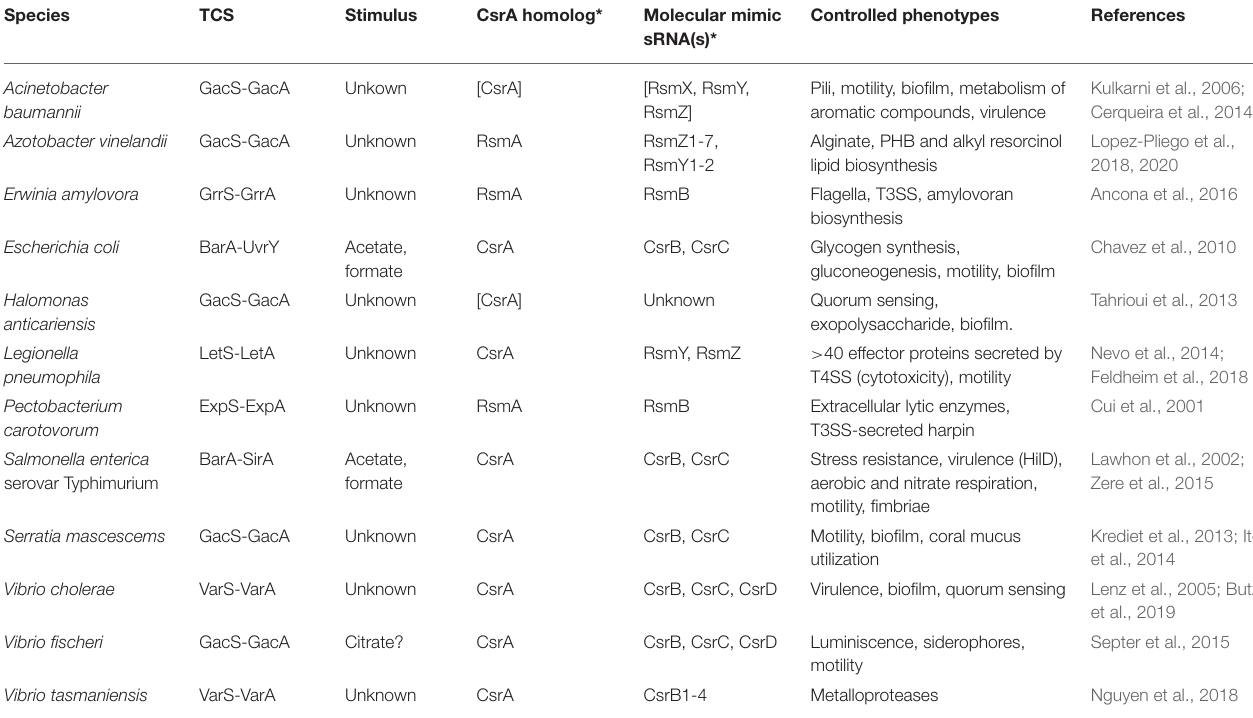
TABLE 1 | Signal transducing two-component systems and their cognate posttranscriptional modules involving CsrA homologs and CsrA-antagonistic sRNAs in γ -proteobacteria.